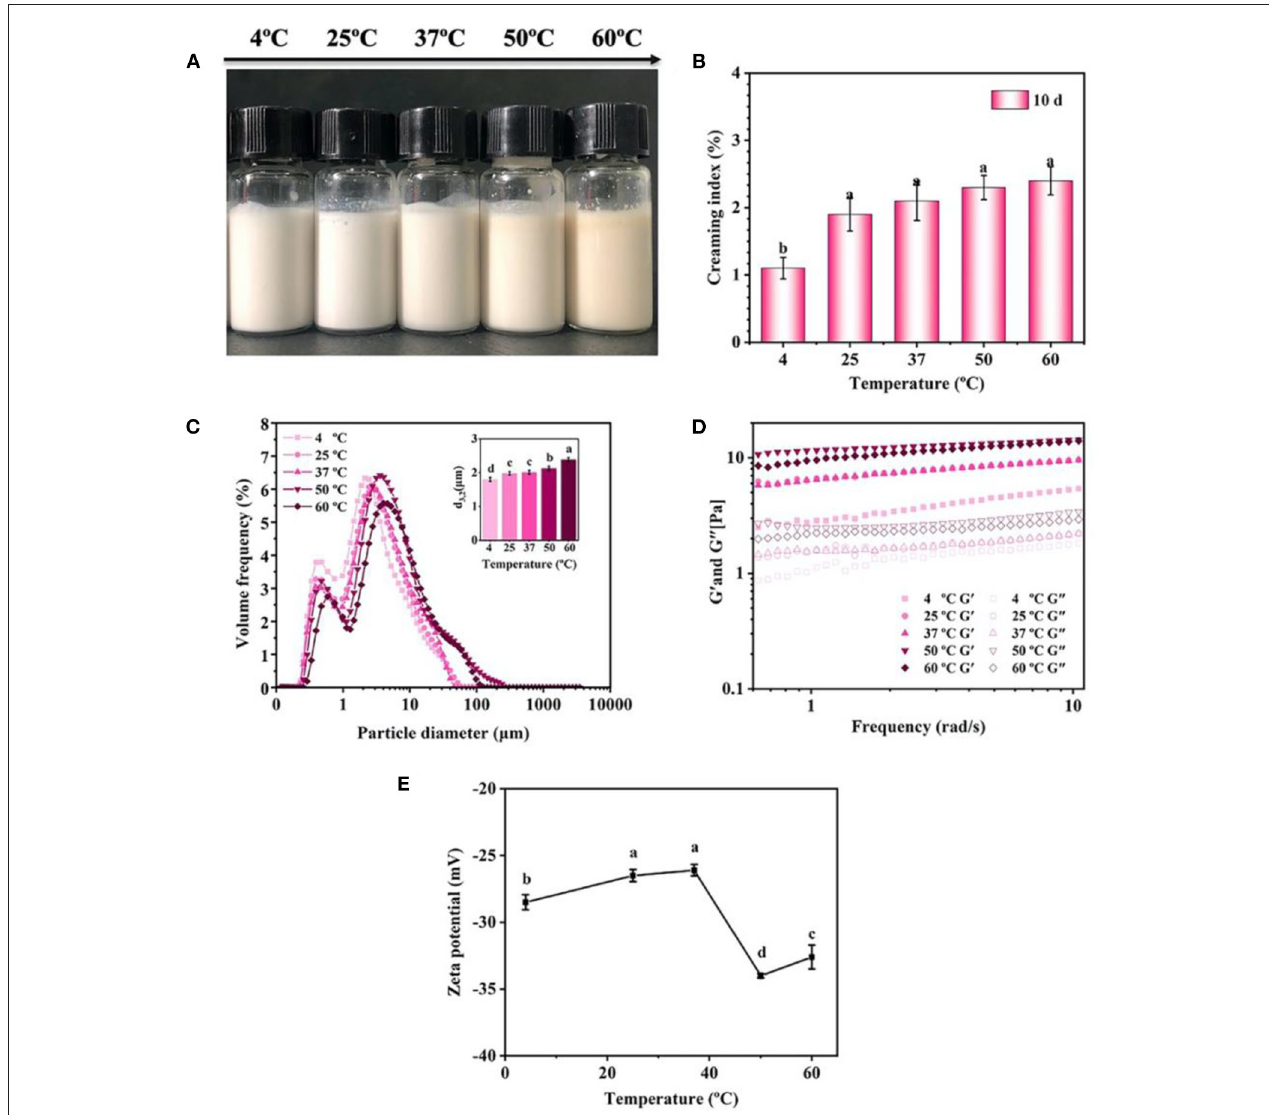
FIGURE 8 | Effects of storage temperature on the visual appearance (A) , creaming index (B) , droplet size (C) , rheological properties (D) , and ζ -potential (E) of the emulsions (pH 7) prepared by 2% proteins and 3:7 oil/water ratio after 10 days storage. Mean values followed by different letters are significantly different ( P <